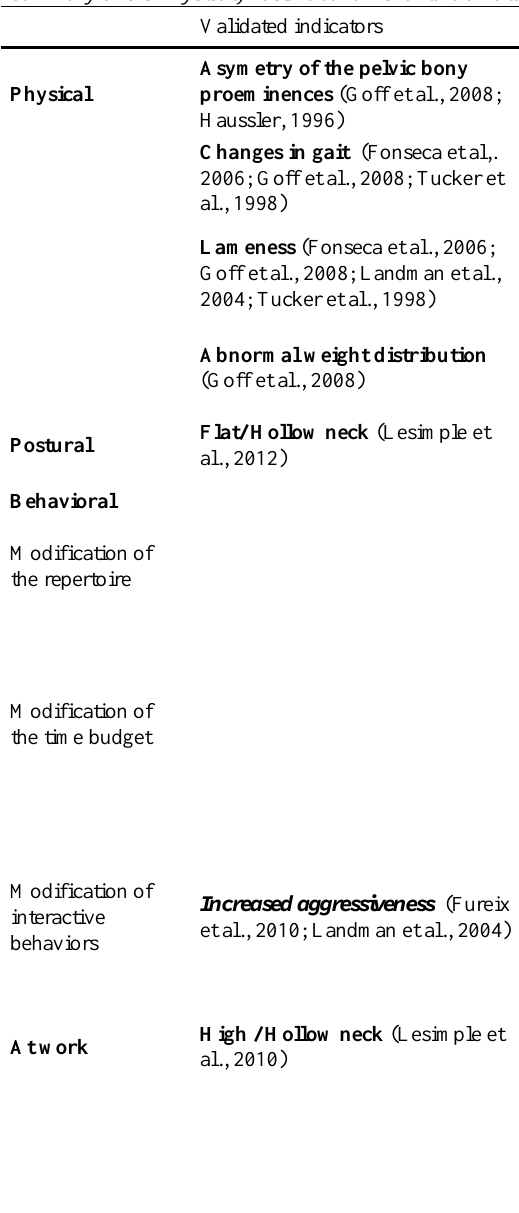
Summary of the Physical, Postural and Behavioral Indicators Related to Back